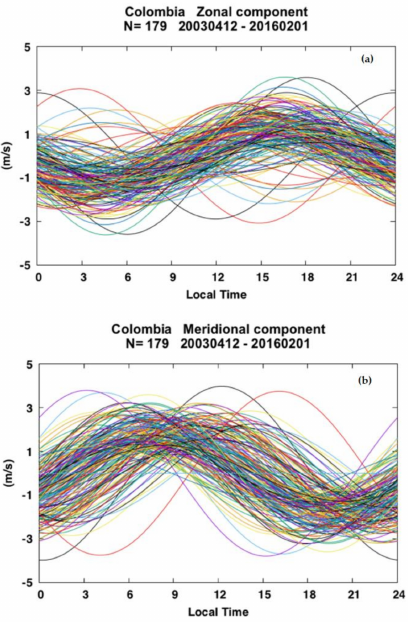
Figure 4. Diurnal wind components estimated from analysis of all data (179 cases) between 12 April 2003 and 1 February 2016, for a location just offshore of Colombia. ( a ). Zonal ( u ) component. ( b ) Meridional ( v )